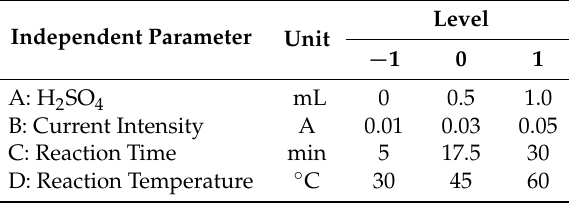
Table 1. Levels for parameters in actual values.